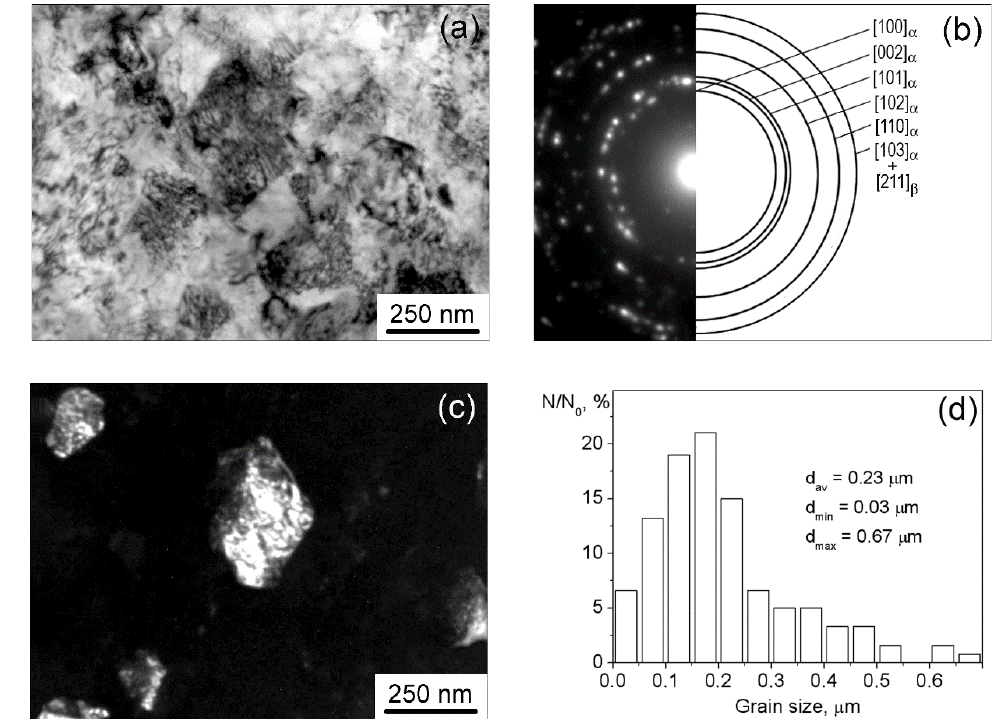
Figure 2. TEM images of the UFG Ti-2.9Al-4.5V-4.8Mo alloy: ( a ) bright-field image and ( b ) corre- sponding SAED; ( c ) dark-field image in the reflection of (002) α type; ( d ) size distribution of grain–subgrain elements.